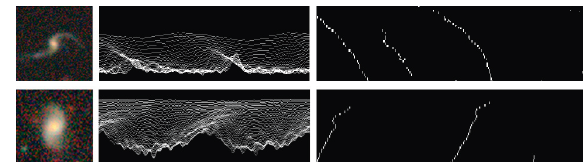
Figure 1: Examples of the peaks of the radial intensity plots of different galaxy images. The direction of the lines generated by the peaks identifies the curves of the galaxy arms and therefore can be used to determine the spin direction of the galaxy. The algorithm is fully symmetric and is not based on complex nonintuitive data- driven rules commonly used in machine